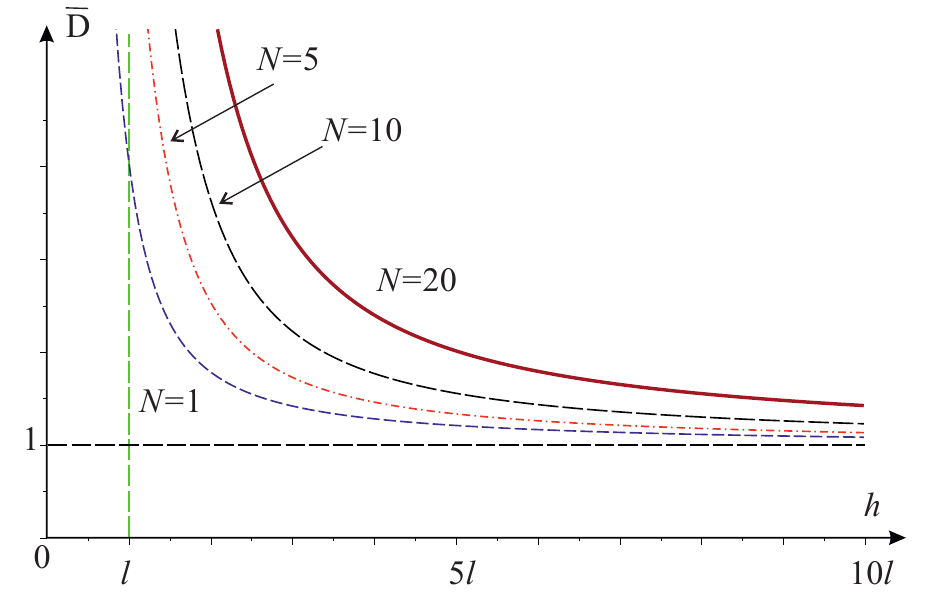
Figure 3. Dimensionless bending stiffness D vs. number of layers N